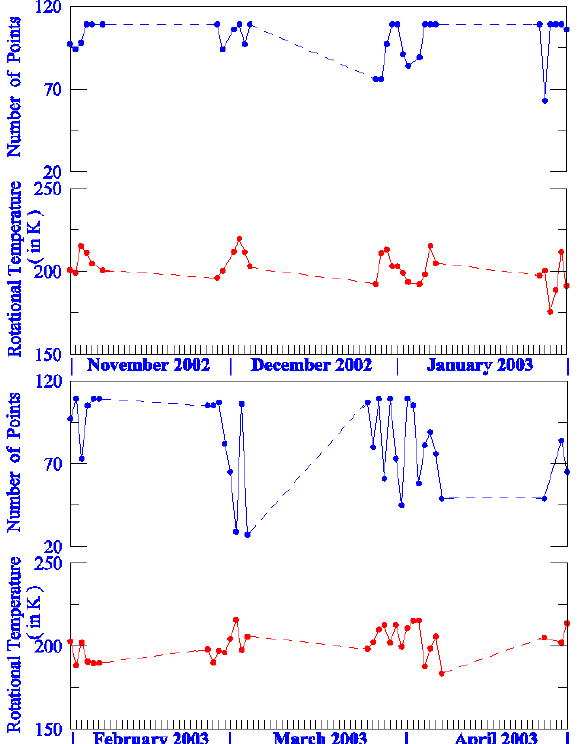
Fig. 3. Mean nightly rotational temperature for the period 1 Novem- ber 2002 to 29 April 2003. The number of temperature measure- ments from which each mean is derived is also plotted in the figure.